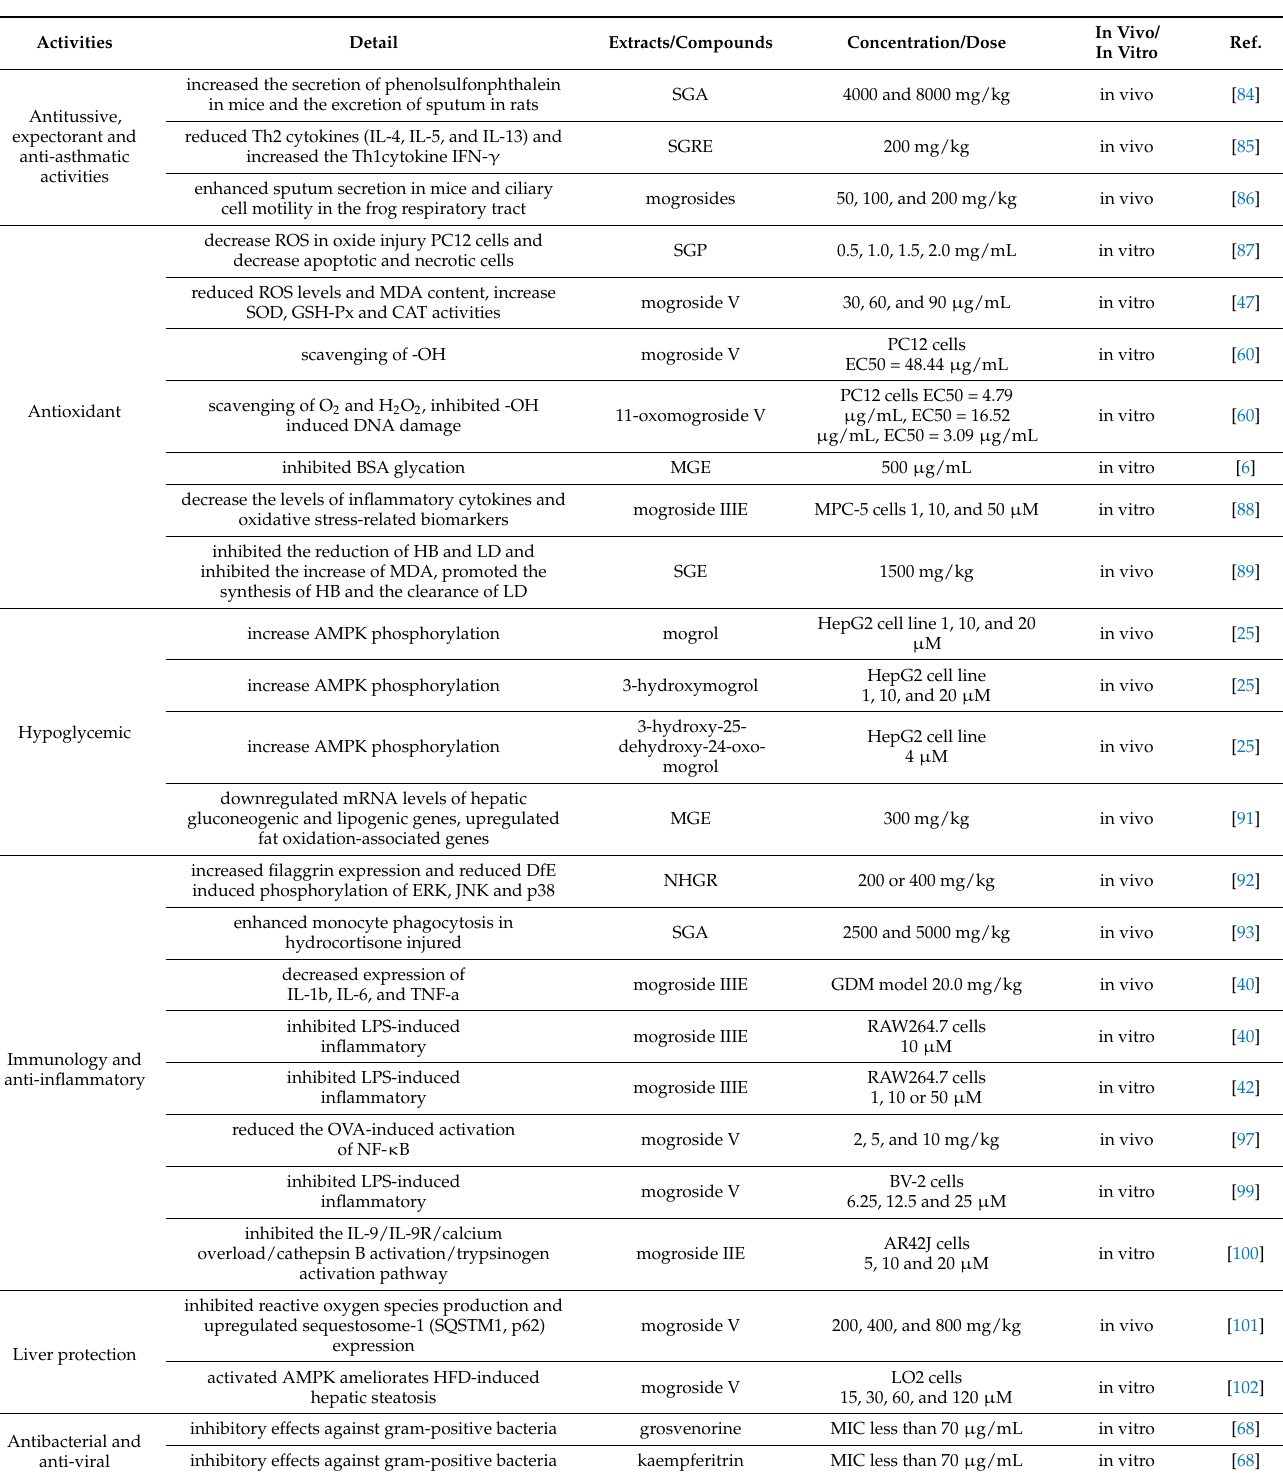
Table 4. Pharmacological activities of S. grosvenorii